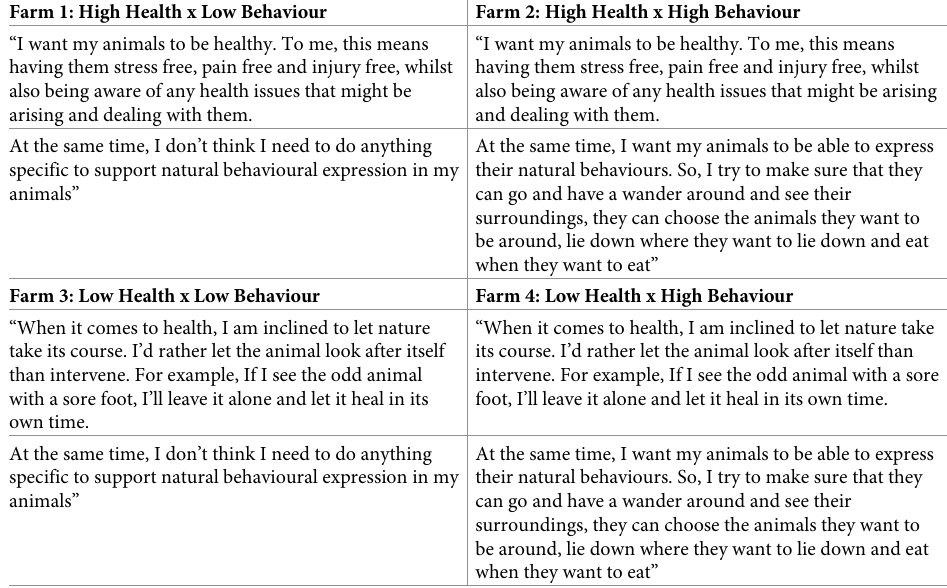
Farm 1: High Health x Low Behaviour Farm 2: High Health x High Behaviour